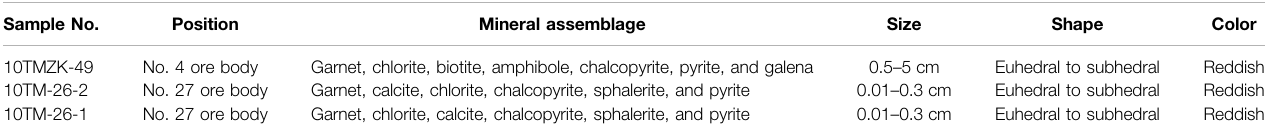
TABLE 1 | Sampling description of two garnet generations in the Tiemurt deposit. Sample No.